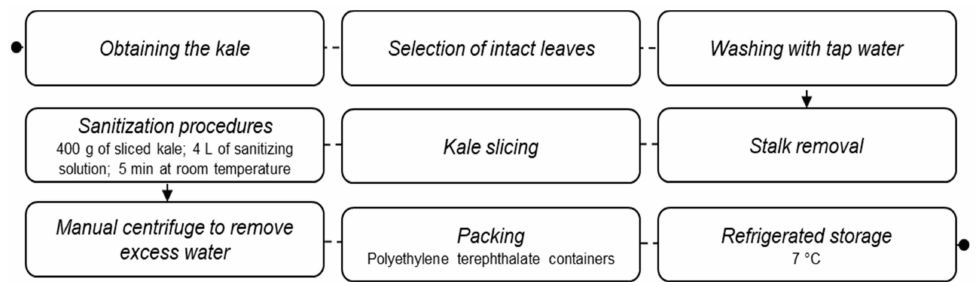
Figure 1. Flowchart of obtaining and processing minimally processed (ready-to-eat) kale used in this